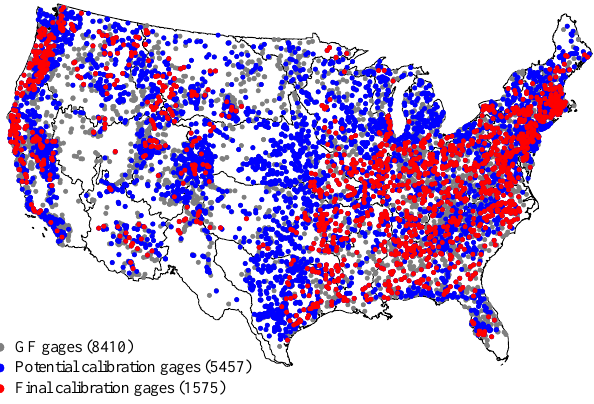
Figure 7. Streamgages tested in the study. GF notes geospatial fab- ric for national hydrologic modeling (Viger and Bock,